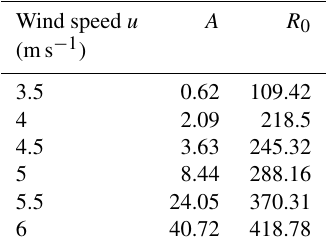
Table 2. Coefficients of A and R 0 for different wind speeds u